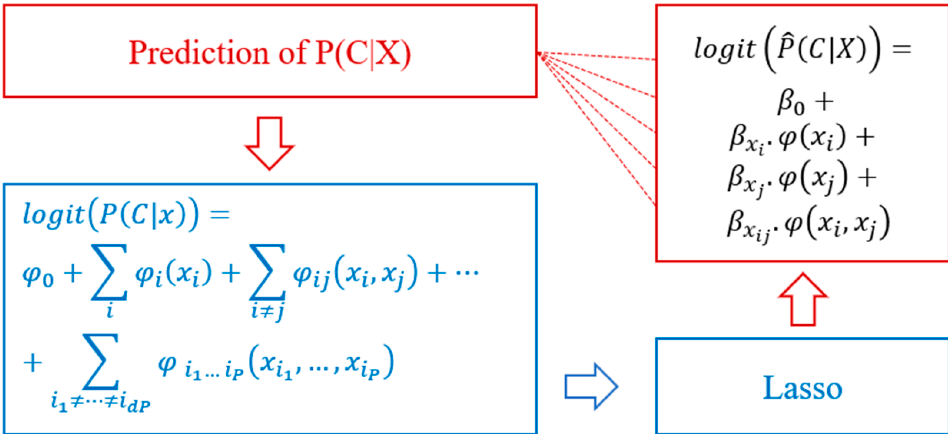
Figure 1. Schematic of the PRiSM framework. Any multidimensional decision function can be represented by a spectrum of additive functions, each with only one or two inputs. The final prediction of the probability of class membership, ˆ P ( C | X ) , is given by the sum of the univariate and bivariate component functions, scaled by the coefficients β x and selection operator (LASSO). Since only univariate ϕ ( x i ) and bivariate ϕ functions are in the model, their shapes provide a route towards interpretation by end-users.